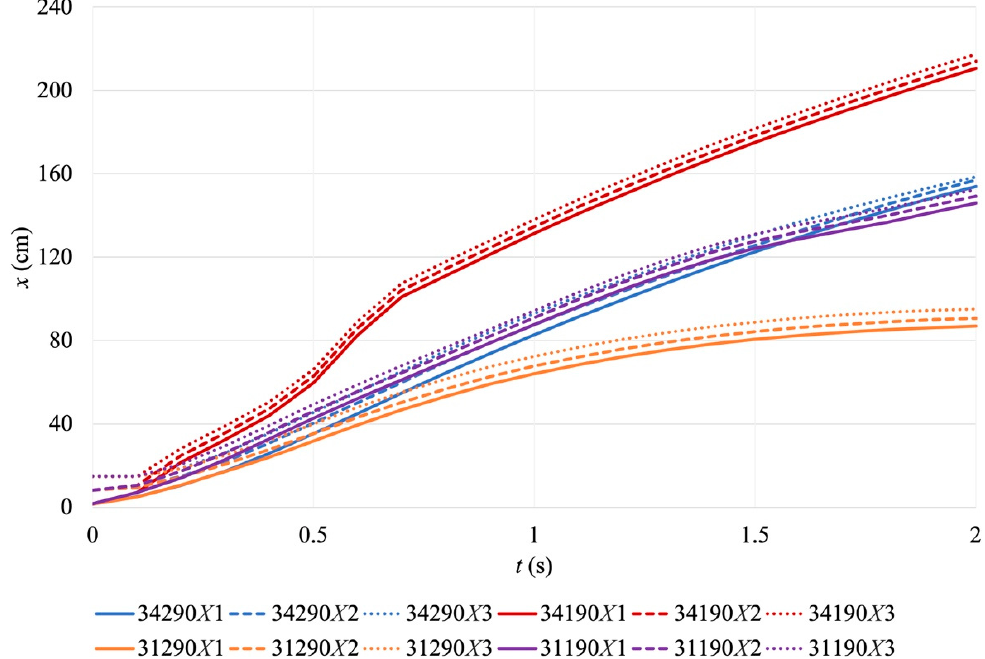
Figure 18. Comparison of the location of each column’s center of gravity in the x direction after starting the drift.